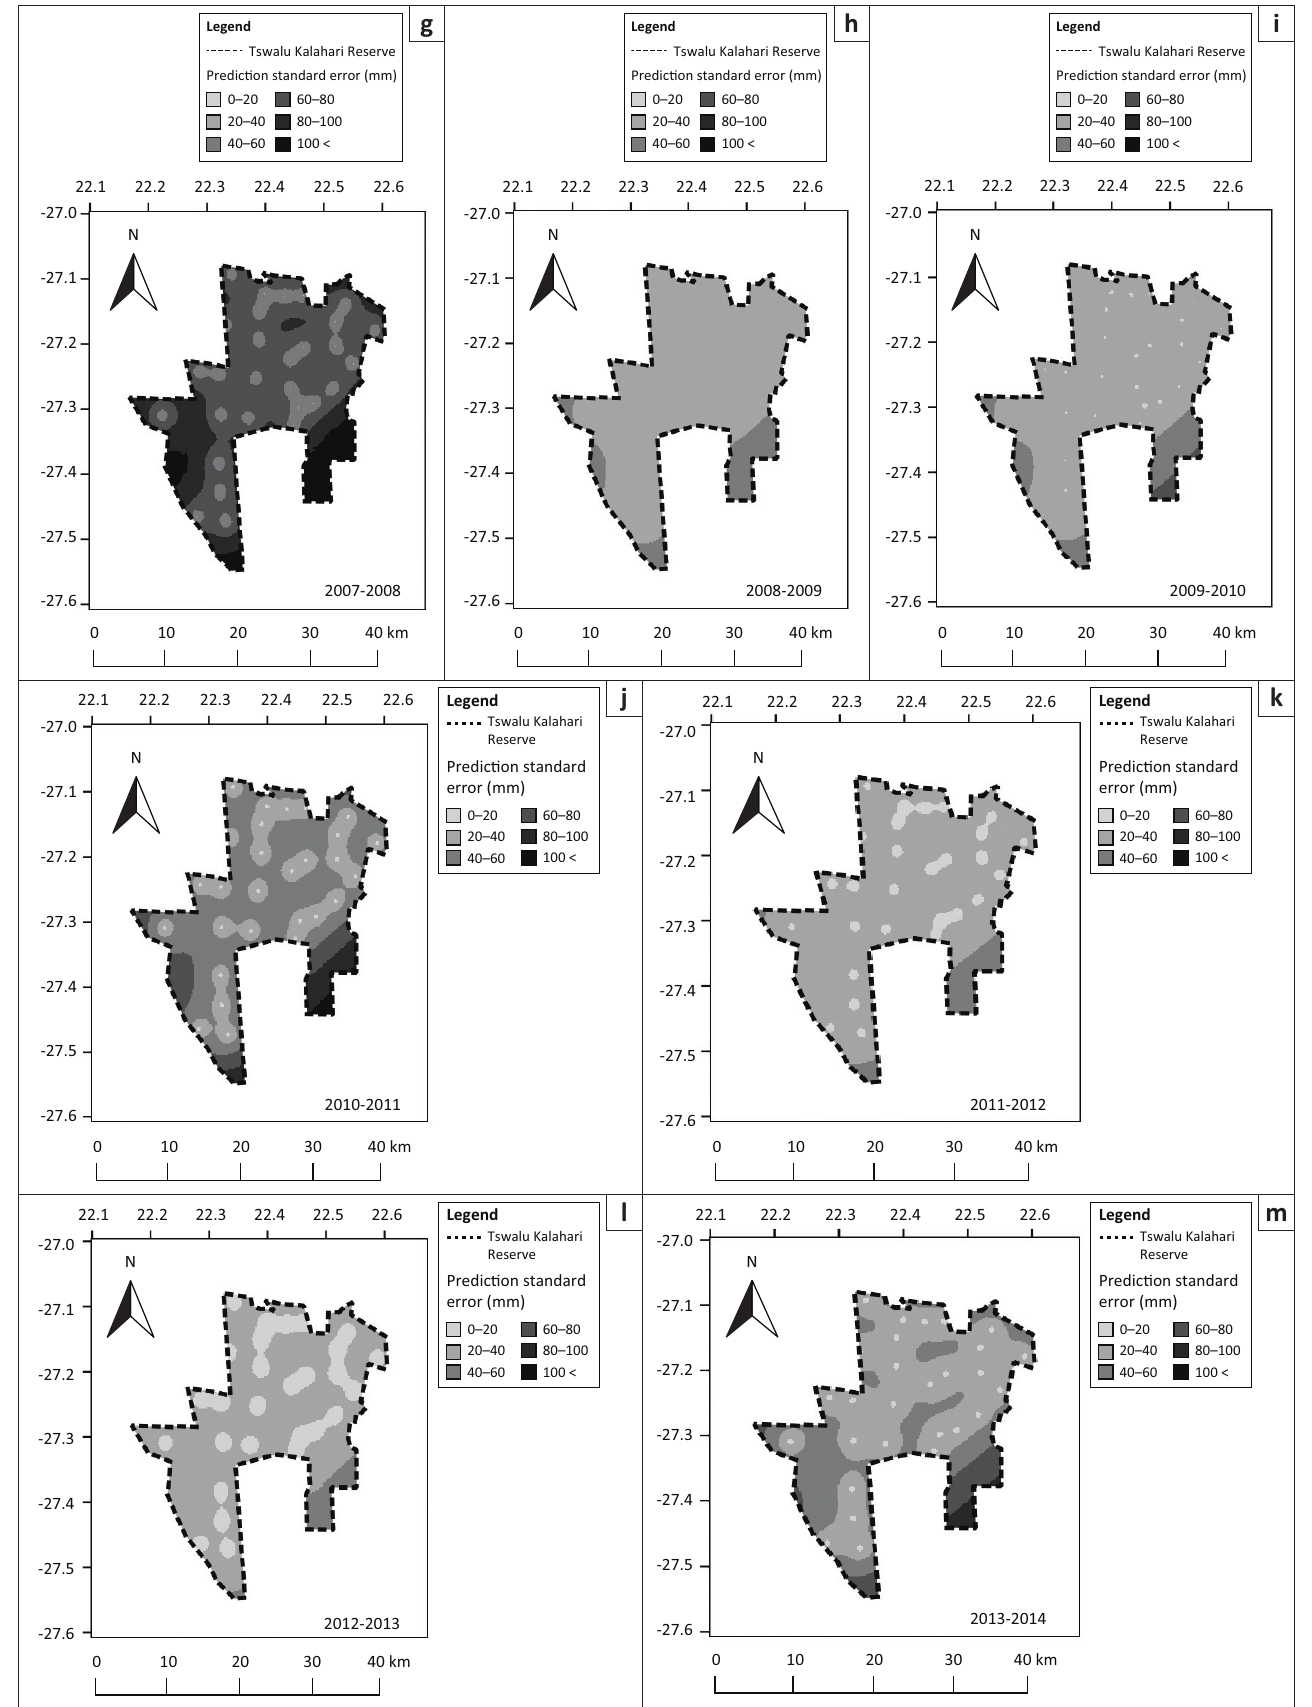
FIGURE 1-A2 (Continues...): Maps of prediction standard error of rainfall surface (Figure 4) in the Tswalu Kalahari Reserve. (a) 2001–2002, (b) 2002–2003, (c) 2003–2004, (d) 2004–2005, (e) 2005–2006, (f) 2006–2007, (g) 2007–2008, (h) 2008–2009, (i) 2009–2010, (j) 2010–2011, (k) 2011–2012, (l) 2012–2013 and (m)